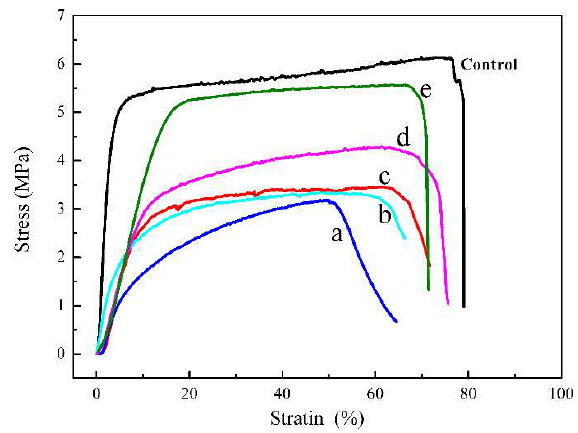
Figure 8. Tensile test of PDLLA/nHA composite fibrous membranes. Table 2. Tensile strength and modulus of PDLLA/nHA composite fibrous membranes.